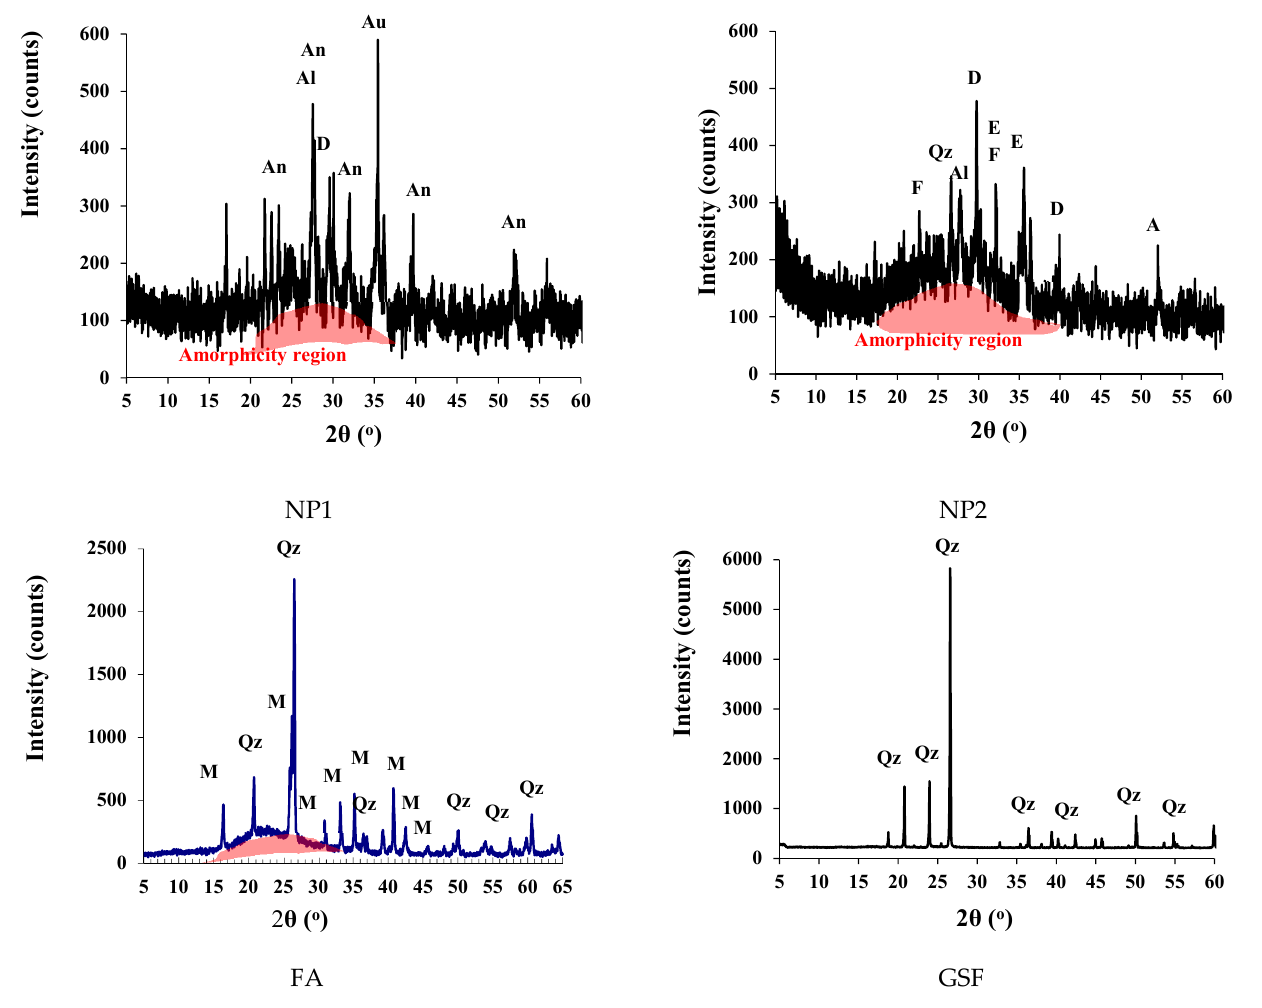
Figure 5. XRD analysis of fine powders. Al: albite, An: anorthite, Au: augite, E: enstatite, D: diopside,